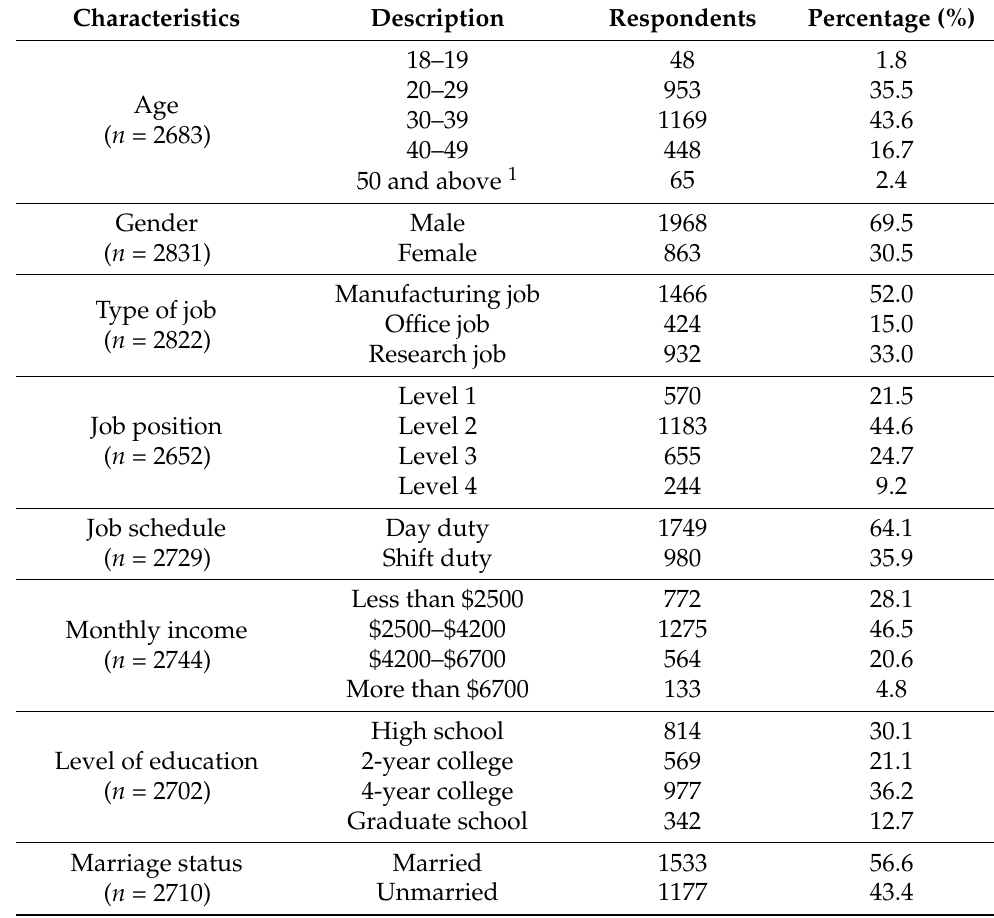
Table 1. Characteristics of the respondents ( n =